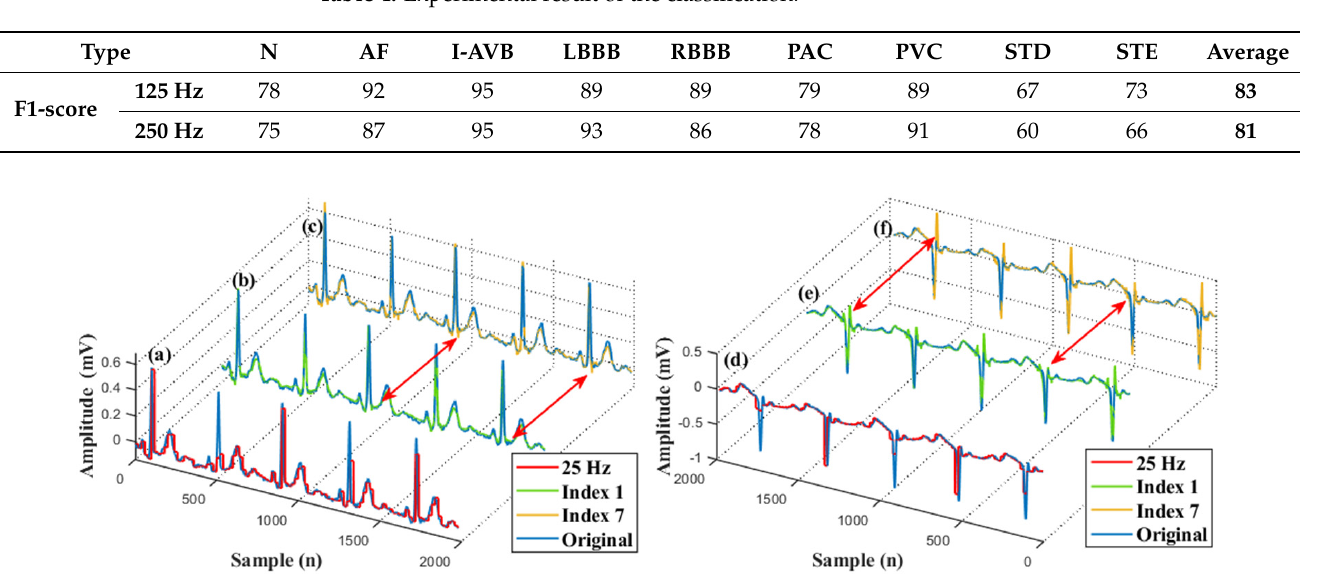
Table 4. Experimental result of the classification.